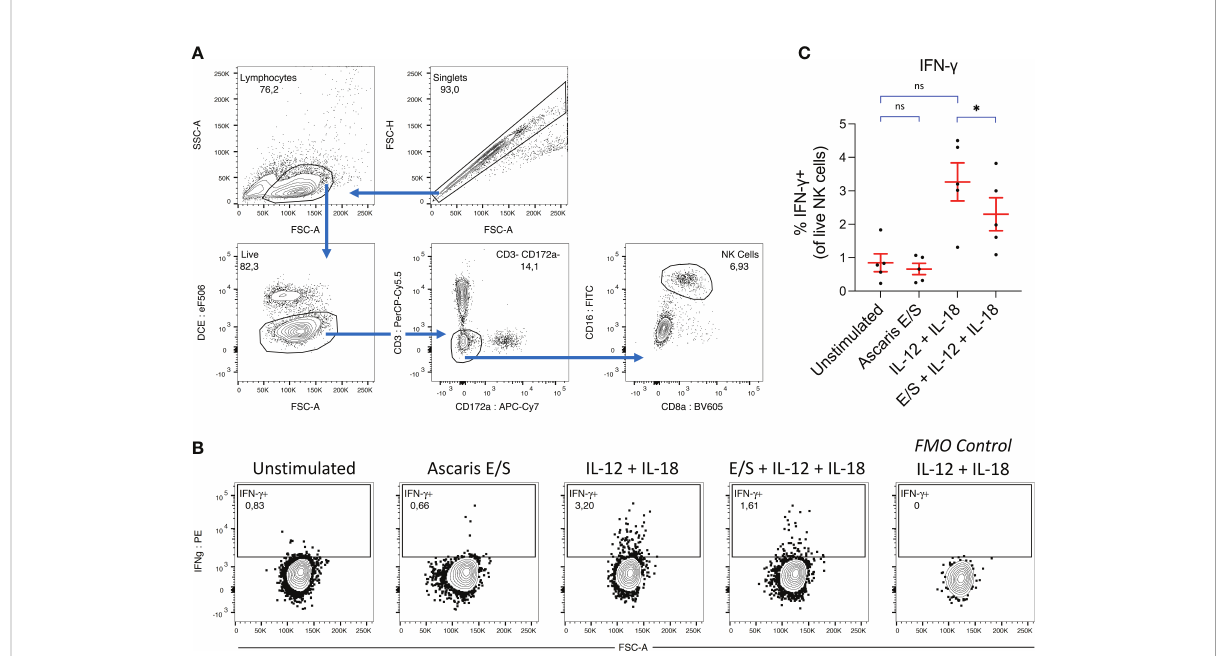
FIGURE 4 Ascaris E/S suppresses IFN- g production by NK cells following IL-12 and IL-18 stimulation. (A) Gating strategy used to identify NK cells in porcine PBMC. Cell aggregates were excluded and lymphocytes were selected based on size (FSC-A) and granularity (SSC-A), before live cells were identi fi ed using a fi xable viability dye. CD3+ and CD172a+ cells were excluded, and from the remaining cells, a distinct CD16+ CD8 low NK cell population was identi fi ed. (B) Representative intracellular IFN- g staining of NK cells from PBMC incubated for 12h with brefeldin A, either unstimulated or stimulated with Ascaris E/S, IL-12p70 + IL-18, or E/S + IL-12p70 + IL-18. Also included is an FMO control sample stimulated with IL-12p70 + IL-18, but not labelled with anti-IFN- g antibody (right). (C) Percentages of IFN- g + cells within the NK cell population identi fi ed as described, within PBMC samples stimulated with the treatments outlined above. Each dot represents cells from different pig, n = 5. Asterisks indicate statistical signi fi cance by paired t test with Bonferroni correction; * p ≤ 0.017. ns, not signi fi